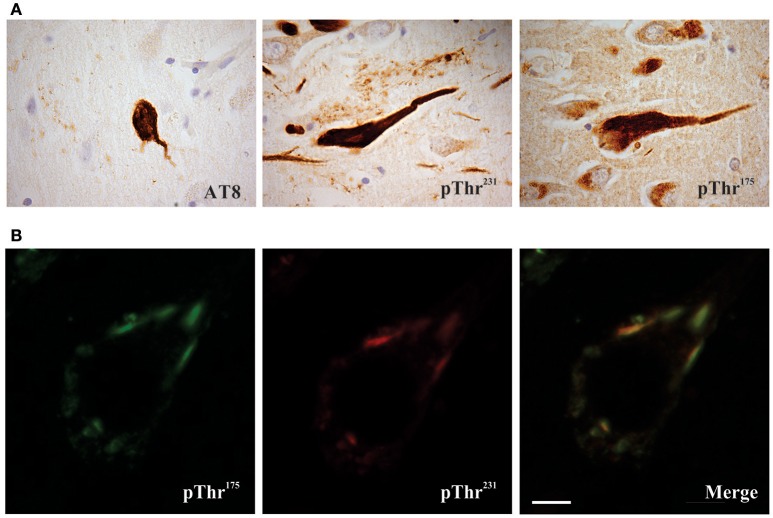
Phosphorylated tau pathology in amyotrophic latera sclerosis with cognitive impairment (ALSci) hippocampal neurons. (A) Immunohistochemical probing with AT8 (pSer202, pThr205), pThr175, pThr231 all reveal positive inclusions in ALS hippocampal neurons. Images taken with a 100x objective. (B) Representative image of pThr175 and pThr231 co-localization in ALSci hippocampal neuron. Scale bar = 5 μm.